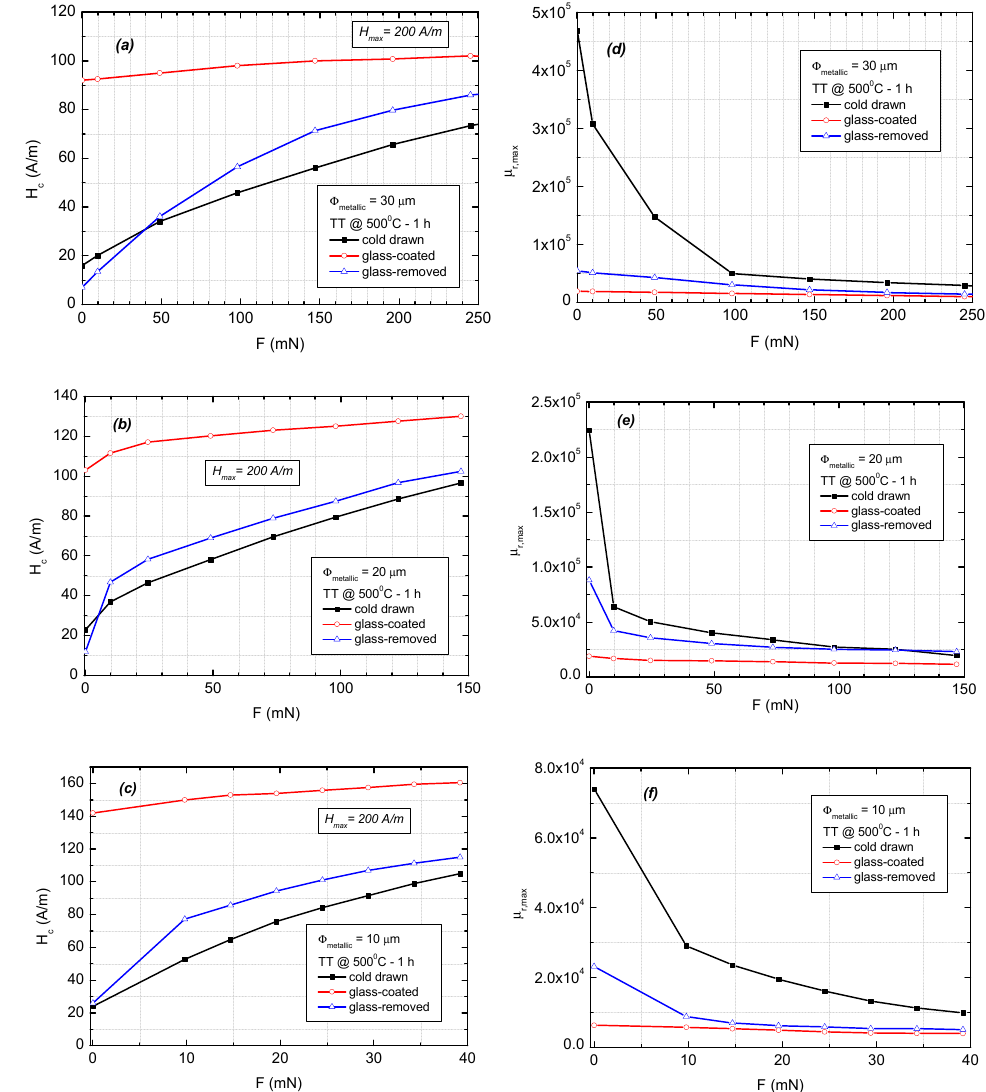
Figure 5. Variation of coercivity ( a – c ) and maximum value of the magnetic permeability ( d – f ) versus applied tensile force, measured on the annealed (500 ◦ C—1 h) Fe 73.5 Si 13.5 B 9 Cu 1 Nb 3 cold-drawn, applied tensile force, measured on the annealed (500 °C—1 h) Fe 73.5 Si 13.5 B 9 Cu 1 Nb 3 cold-drawn, glass- glass-coated, and glass-removed microwires, with 30 µ m, 20 µ m, and 10 µ m metallic core diameters, coated, and glass-removed microwires, with 30 µm, 20 µm, and 10 µm metallic core diameters, re- spectively. Sample length: l s = 10 cm. respectively. Sample length: l s = 10